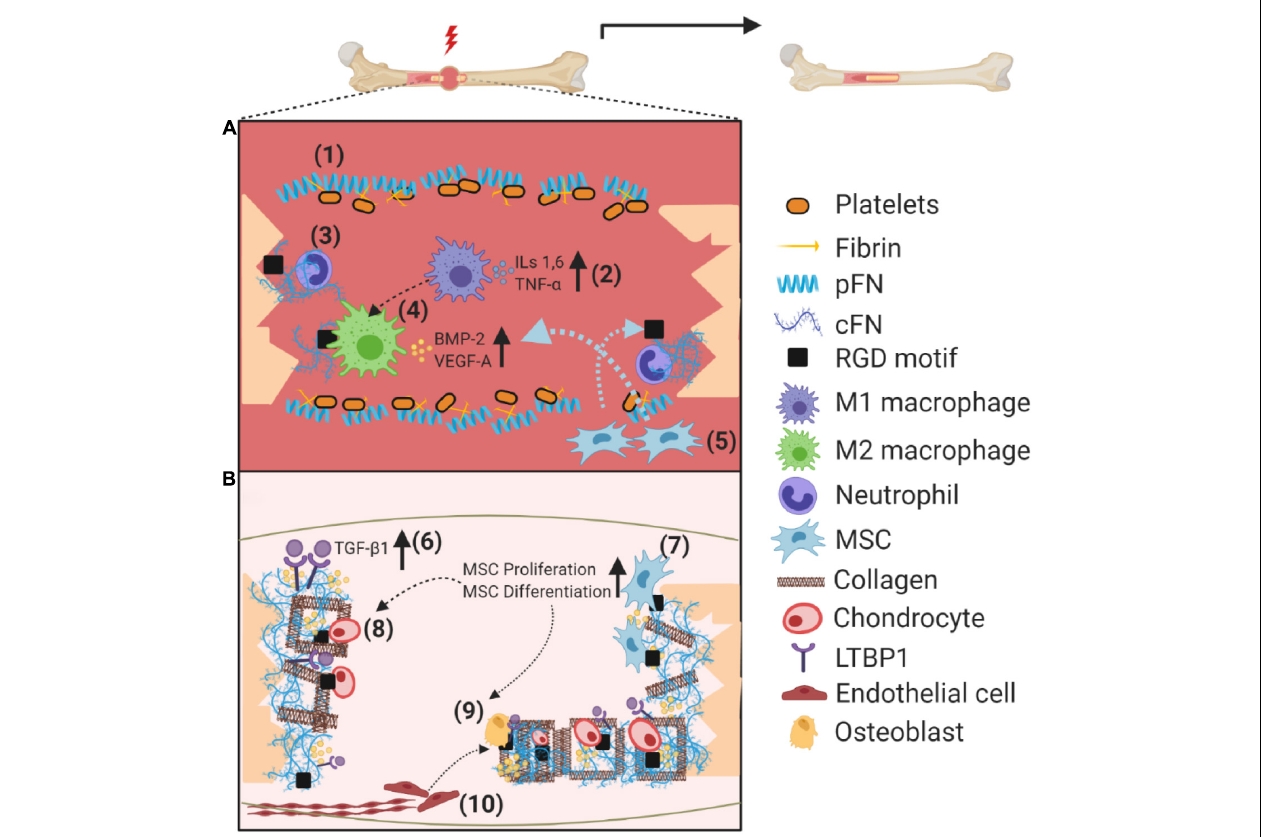
FIGURE 1 | Schematic illustration on the role of fibronectin (pFN and cFN) during fracture healing. (A) Soon after the fracture, pFN from the bloodstream in association with fibrin promotes clotting near the fracture site to form a hematoma (1) . Acute inflammation is initiated by macrophages (M1), recruiting further immune cells via cytokine secretion (2) . Neutrophils lay the groundwork for healing by secreting cFN as an “emergency ECM” (3) . Cell binding to cFN RGD motifs switch macrophages to an anti-inflammatory (M2) phenotype, which secrete growth factors to recruit, among others, MSCs and ECs (4) . Recruited MSCs infiltrate injury site and dock on integrin binding sites (5) . (B) cFN orchestrates the deposition of additional proteins such as LTBP1 and collagen to the ECM, increasing availability of TGF- β ligands, along with entrapment of additional growth factors such as BMP-2 (6) . MSCs bound to cFN increase their proliferation rate via integrin signaling, followed by differentiation toward chondro/osteoprogenitors (7) . Docking to cFN and growth factor regulation promotes cartilage formation via chondrocytes to stabilize the fracture (8) . Attachment and proliferation of osteoblasts is promoted by integrin signaling, forming the hard callous (9) , coupled to the recruitment/proliferation of endothelial cells and establishment of new vasculature also in part via integrin signaling (10) . Abbreviations used: plasma fibronectin (pFN), cellular fibronectin (cFN), mesenchymal stem cell (MSC), latent TGF-binding protein 1 (LTBP1), transforming growth factor β (TGF- β